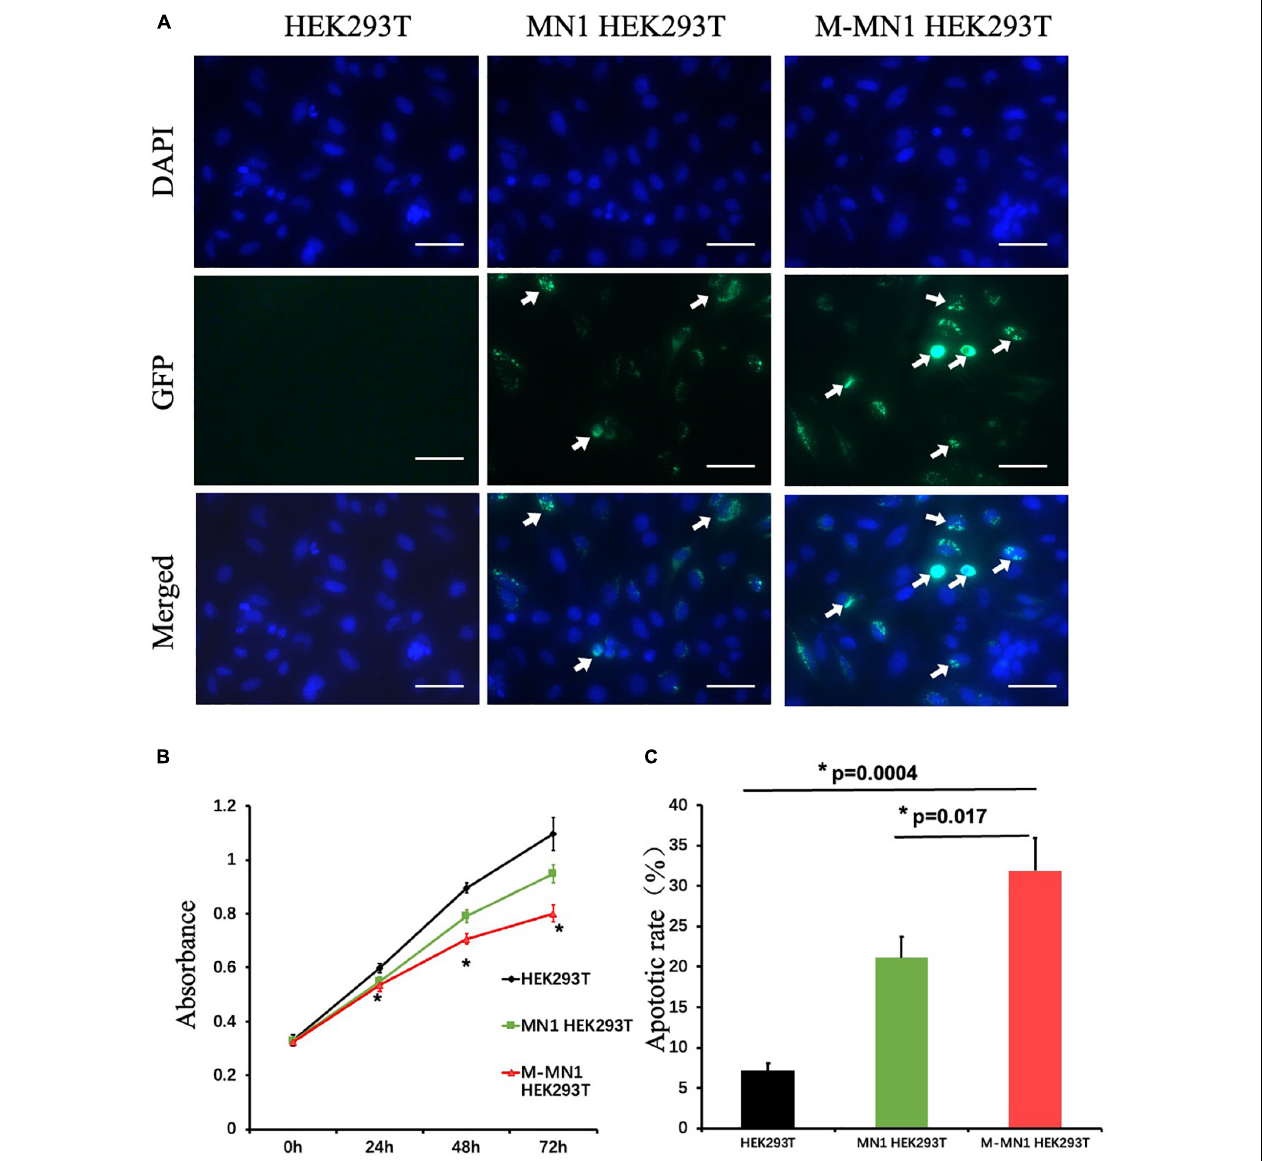
FIGURE 2 | (A) Immunofluorescence of GFP-fused MN1 and M-MN1 showing the subcellular localization and aggregation of MN1 proteins in HEK239T cells. The arrows pointed out the represented MN1 fluorescence. Scale bars represent 50 mm. (B) Cell proliferation at 0, 24, 48, and 72 h after transinfection. The cell numbers indicated by the absorbance at 450 nm were significantly lower in transinfected groups ( t -test, p = 0.017). And the M-MN1 group had the lowest absorbance reading across all time points; at 48 and 72 h the readings of M-MN1 group were significantly lower compared to MN1 group ( t -test, p = 0.009, 0.004, respectively). (C) Cell apoptotic rate was significantly higher in M-MN1 group compared with HEK239T and MN1 group. * p ≤